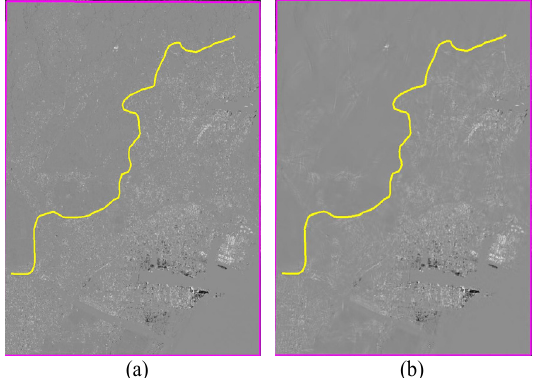
Figure 6. (a) The difference (stretched) image of the pre- and post-event TSX images. The specification of the yellow line is interpreted in the caption of Figure 5. The bright and dark areas indicate the changes caused by various reasons; otherwise, the common gray areas are interpreted as the unchanged areas. (b) The difference image resultant of Curvelet filtering on the one shown in